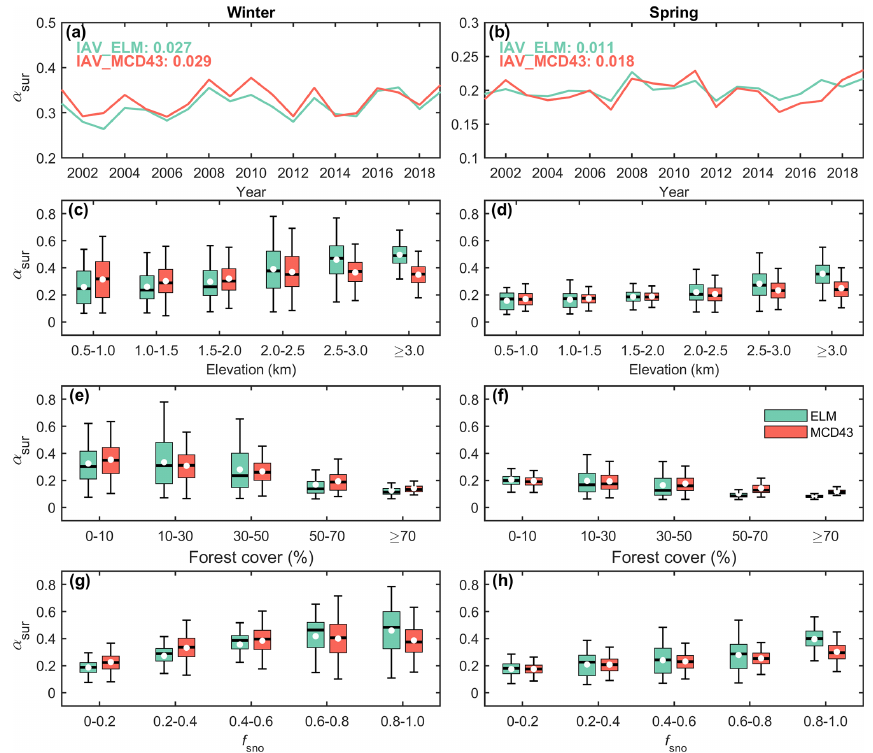
Figure 7. (a, b) Time series of regional average values, (c, d) elevation gradients, (e, f) change with forest cover, and (g, h) statistical distribu- tions of surface albedo ( α sur ) under different snow cover conditions in ELM (green) and MCD43 (red) for different seasons: (a, c, e, g) winter and (b, d, f, h) spring over the WUS. The IAV values of different datasets are shown in (a, b) . In panels (c) – (h) , the white dots represent the average